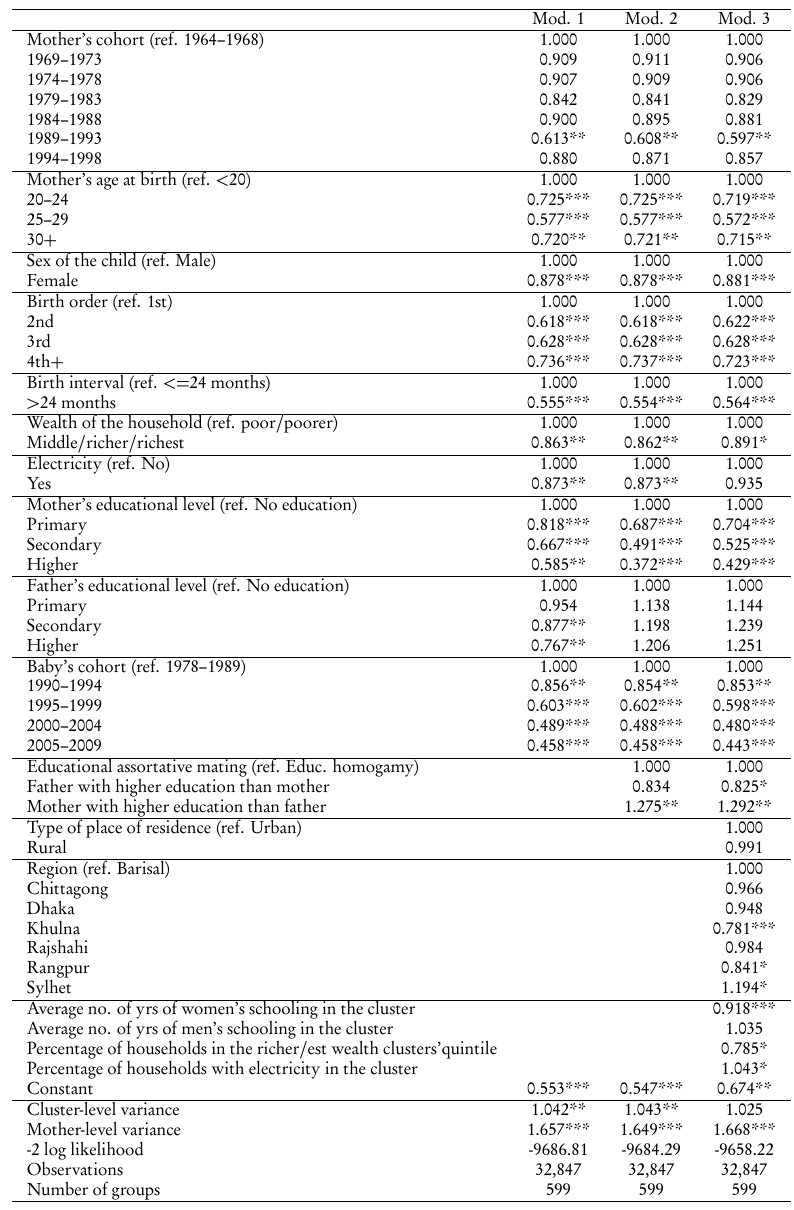
Multilevel logistic regression (odds ratios and significance